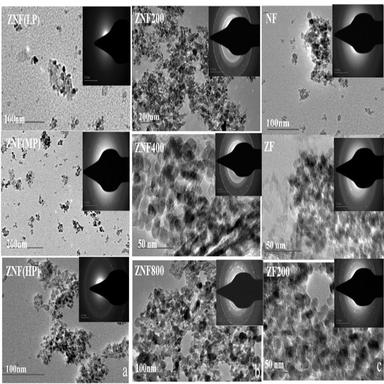
TEM micrograph and SAED pattern of samples a) ZNF(LP), ZNF(MP) and ZNF(HP) b) ZNF200, ZNF400 and ZNF800c) NF and ZF and ZF200.